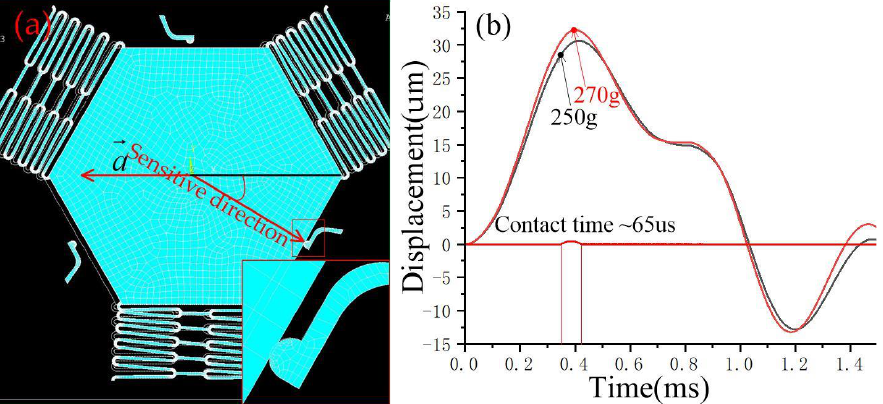
Figure 7. ( a ) Schematic diagram of a movable electrode in contact with a fixed electrode in the directions away from the sensitive direction of 30°; ( b ) the dynamic contact process curves of movable and fixed electrodes in the directions away from the sensitive direction of 30°.